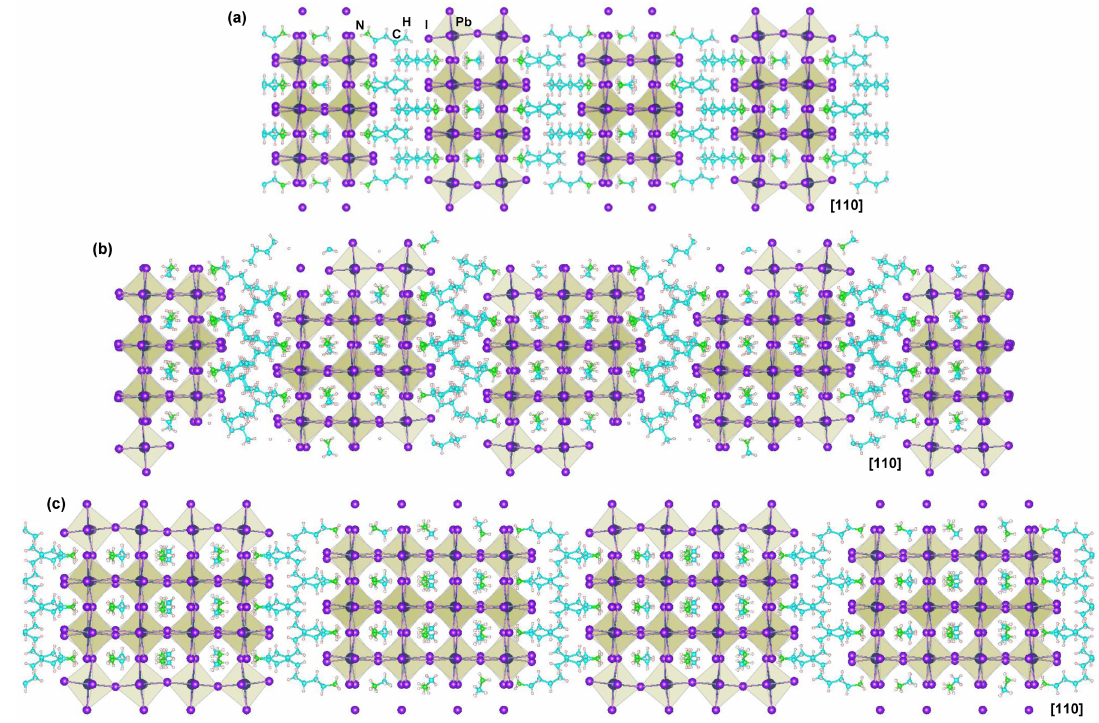
Figure 37: Structural models of (a) (CH 3 (CH 2 ) 3 NH 3 ) 2 (CH 3 NH 3 )Pb 2 I 7 , (b) (CH 3 (CH 2 ) 3 NH 3 ) 2 (CH 3 NH 3 ) 2 Pb 3 I 10 , and (c)